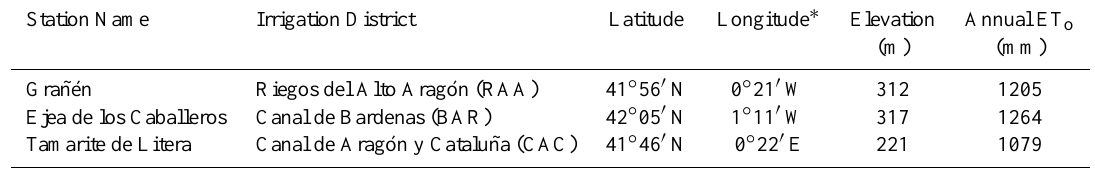
Table 1. Location of the weather stations used. Annual ET o is the long-term average for the period analysed (2004–2011). Station Name Irrigation District Latitude